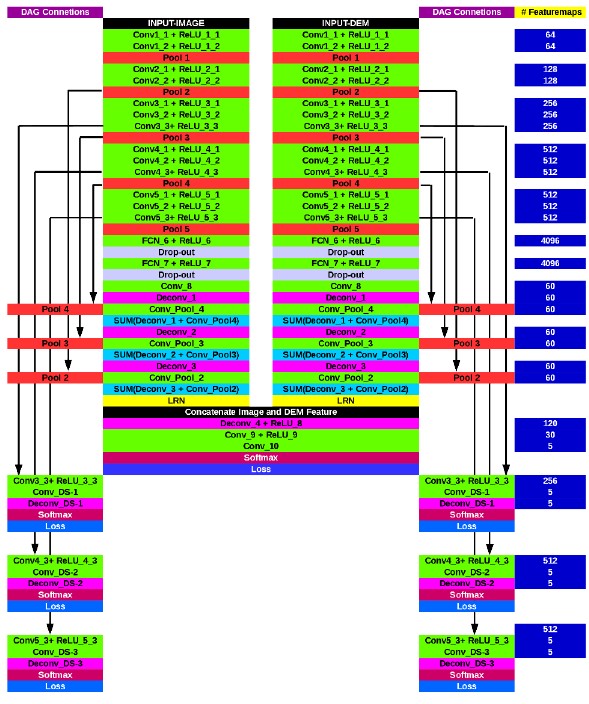
Figure 2: Schematic diagram of our network architecture. Layers and connections on the left, number of kernels per layer on the right. All convolution kernels are 3 × 3 , all max-pooling windows are 2 × 2 , with no